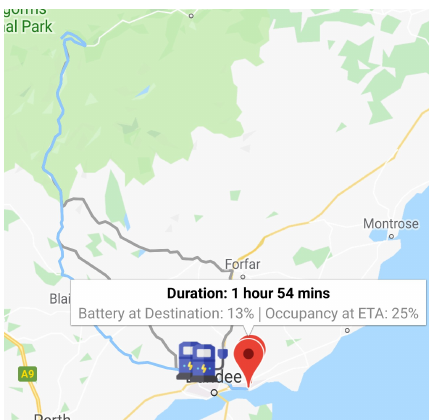
Figure 6. The route to the CS chosen from the decision